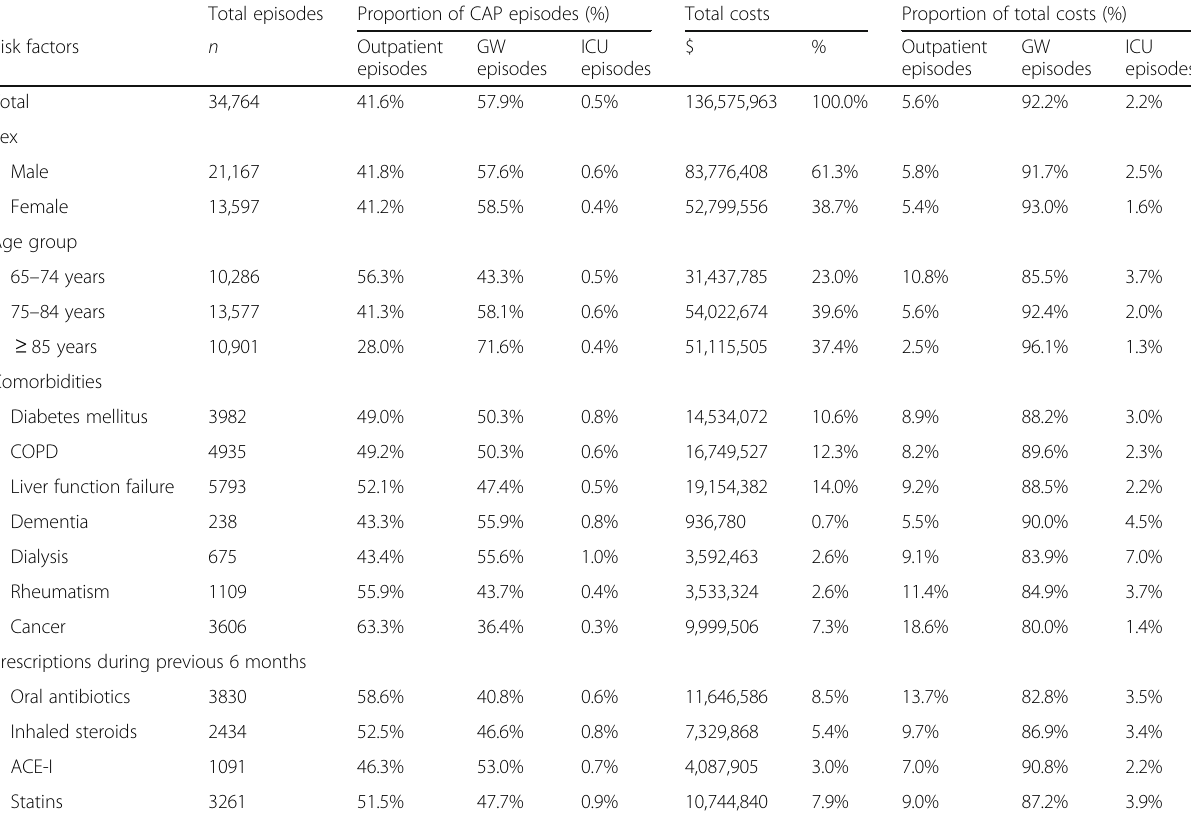
Table 3 A breakdown of all-cause total treatment costs according to risk